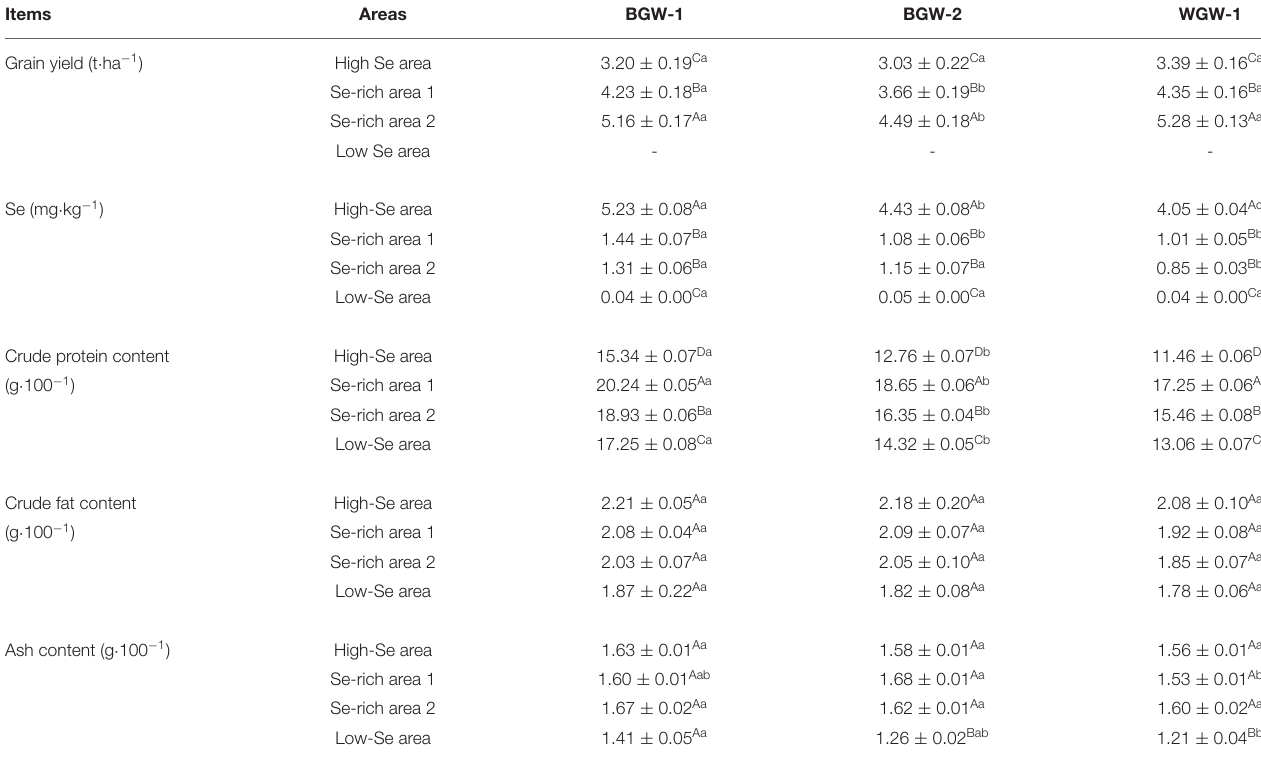
TABLE 1 | Performance of the grain yield, grain selenium (Se) concentration, and nutritional components of wheat in different Se areas.